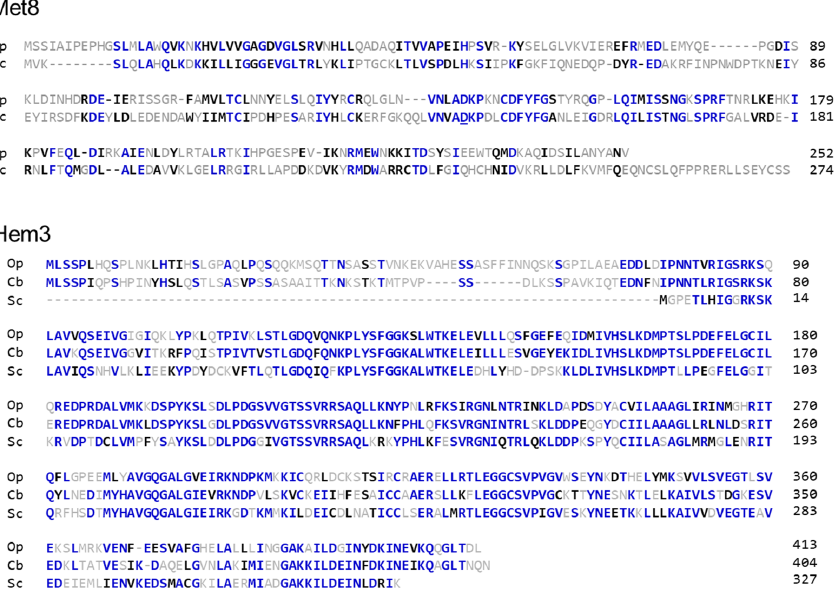
Figure 1. Alignments of deduced protein sequences. Met8, alignment of protein sequences encoded by O. polymorpha (Op) and S. cerevisiae MET8 genes. Hem3, alignment of porphobilinogen deaminase sequences of O. polymorpha (Op), Candida boidinii (Cb), and S. cerevisiae (Sc). Similar residues are shown in black; identical residues are shown in blue. The aspartate residue, which is essential for both dehydrogenase and ferrochelatase activity of the Met8 protein is